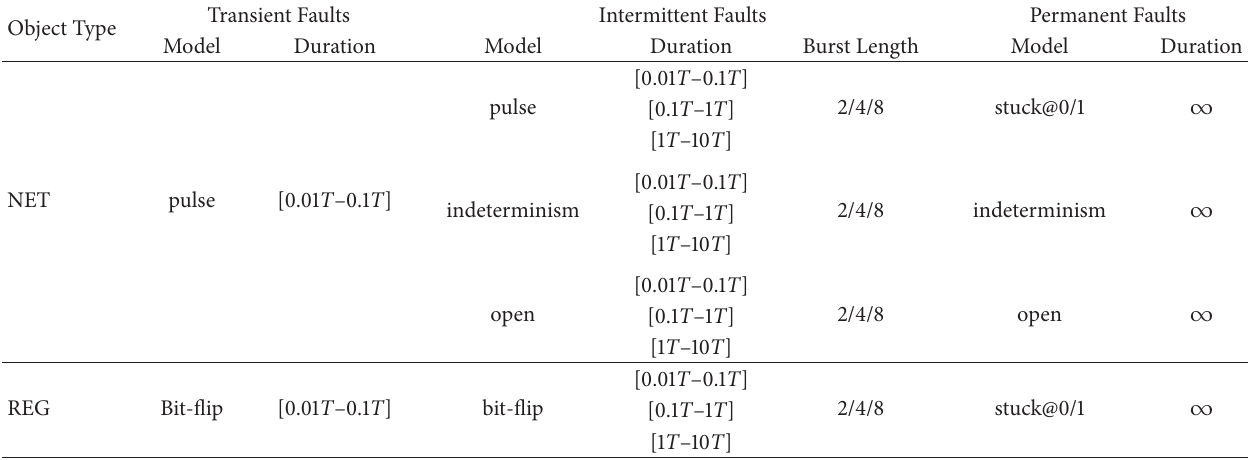
Table 3: Fault injection method.